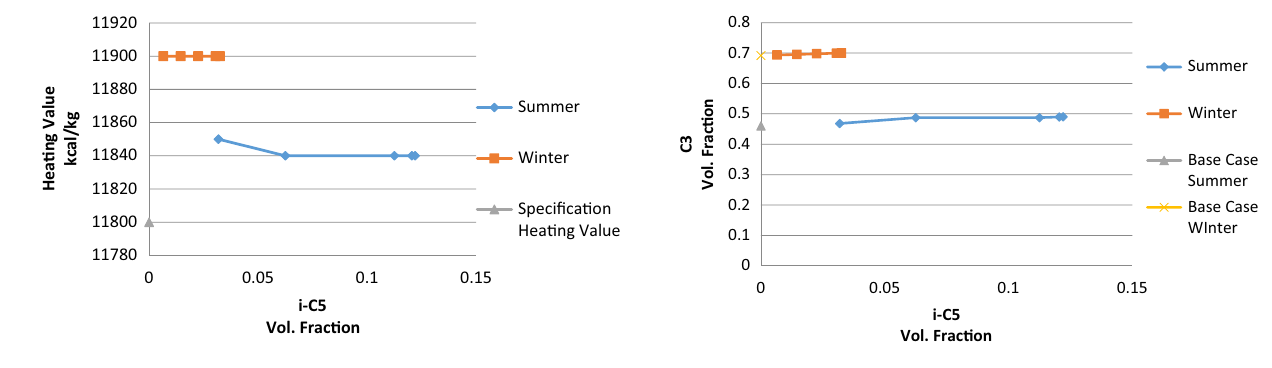
Fig. 7 Effect of adding i-C5 on LPG heating value